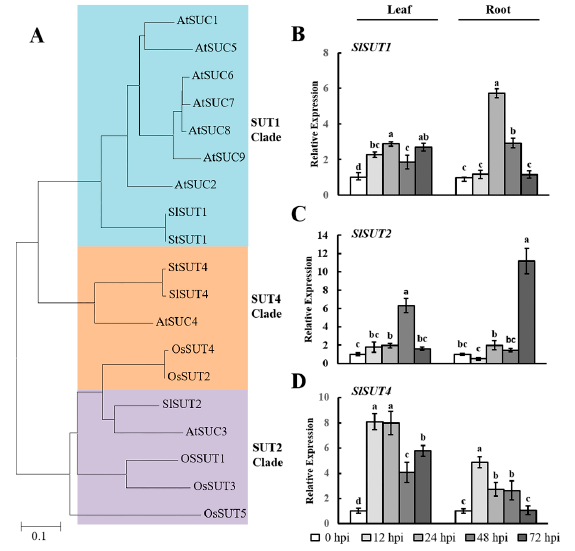
Figure 2. RKN infection-mediated expression of SlSUTs in tomato leaves and roots. ( A ) Phylogenetic analysis of SUT proteins from Arabidopsis thaliana ( At ), Oryza sativa ( Os ), Solanum tuberosum ( St ), and Solanum lycopersicum ( Sl ) . A phylogenetic tree was constructed via the neighbor-joining method with 1000 bootstrap replications. Accession numbers are listed in Supplementary Table S1; ( B – D ) qRT-PCR was used to quantify SlSUT expression at 0, 12, 24, 48, and 72 h postinoculation (hpi) with Meloidogyne incognita . Three biological replicates were analyzed and three technical repeats were performed per sample. Error bars indicate the standard deviation (SD) between biological repeats ( n = 3). Different letters indicate significant differences ( p < 0.05).